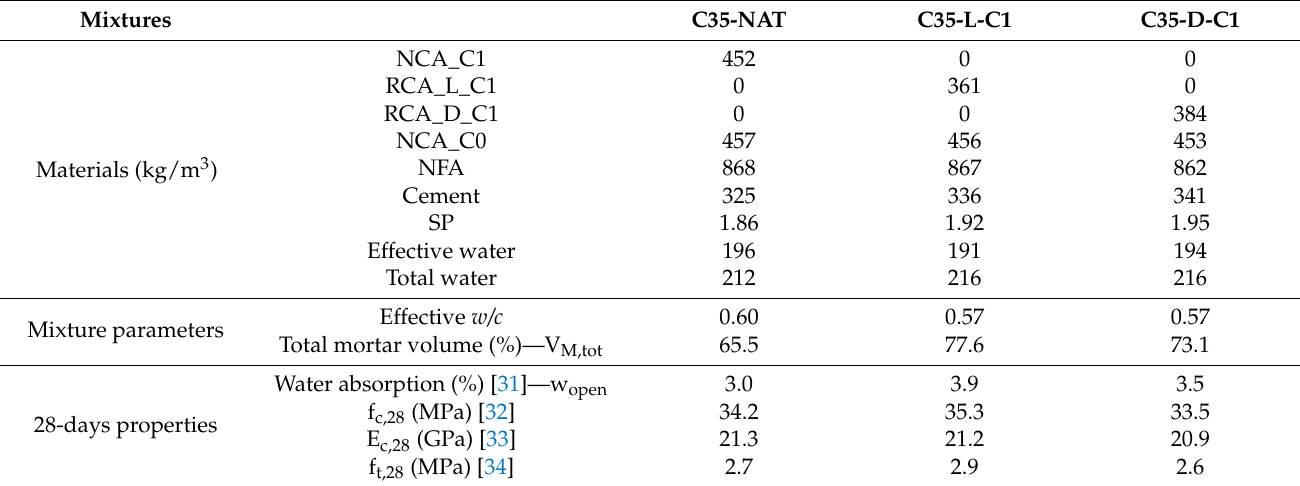
Table 2. Mix proportions and main properties of NAC and RACs used (Rangel et al.